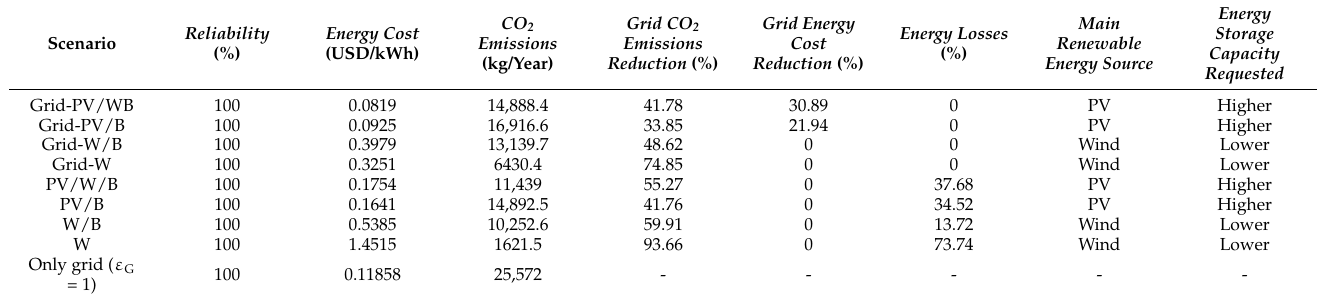
Table 14. Summary of the different evaluation and comparative criteria of the studied systems for ε G =